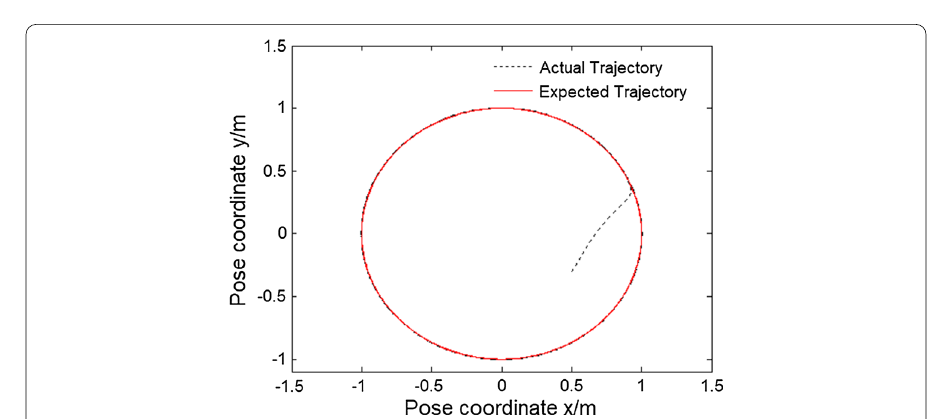
Fig. 6 Effect diagram of circular tracking